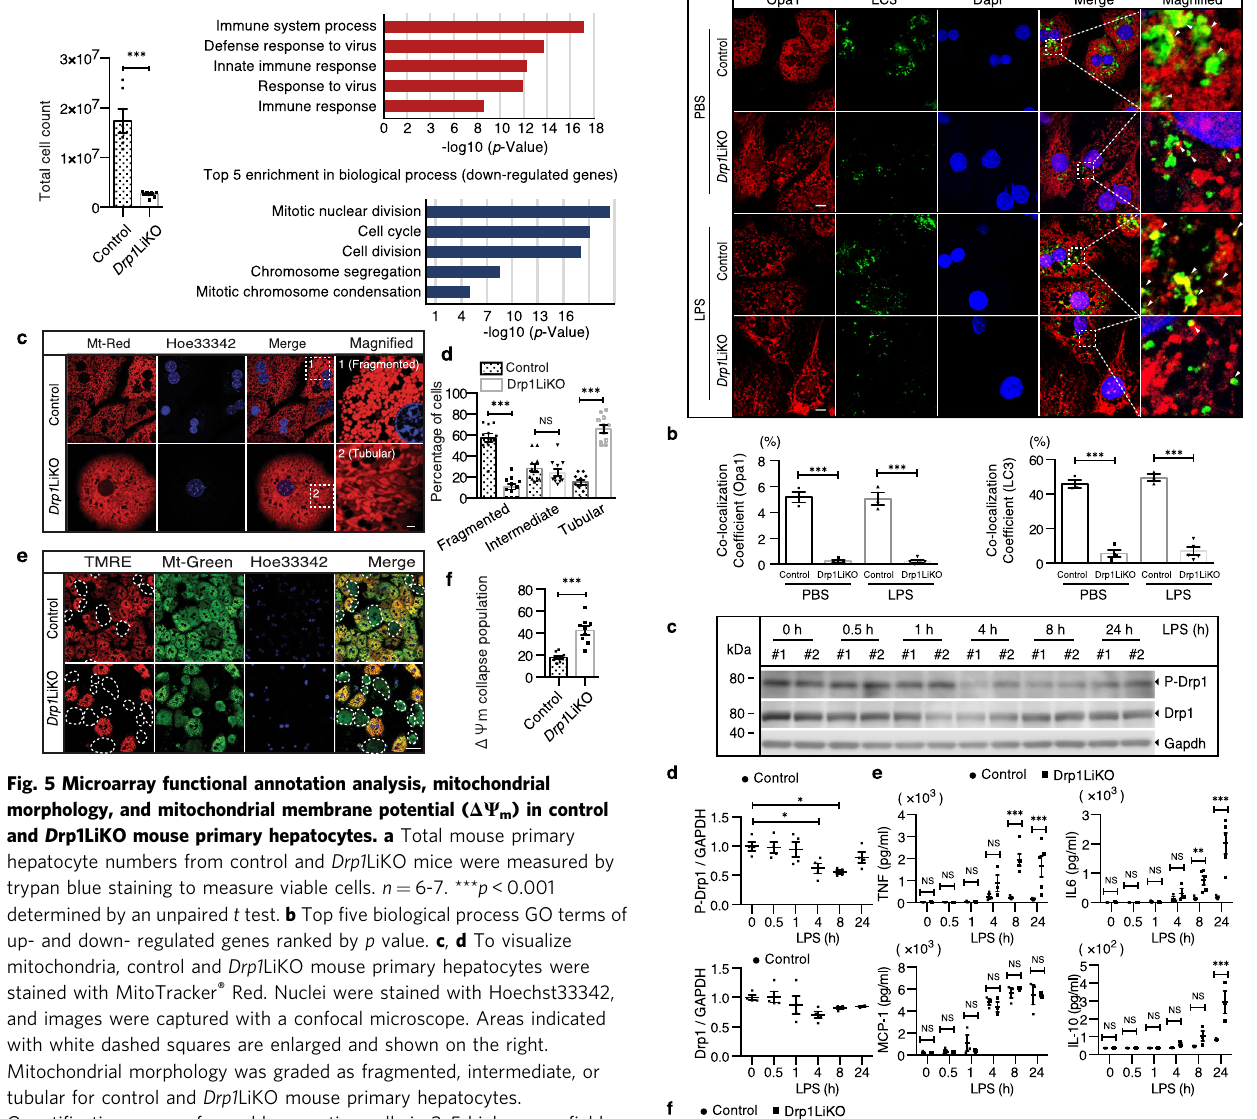
stained with MitoTracker ® Red. Nuclei were stained with Hoechst33342, and images were captured with a confocal microscope. Areas indicated with white dashed squares are enlarged and shown on the